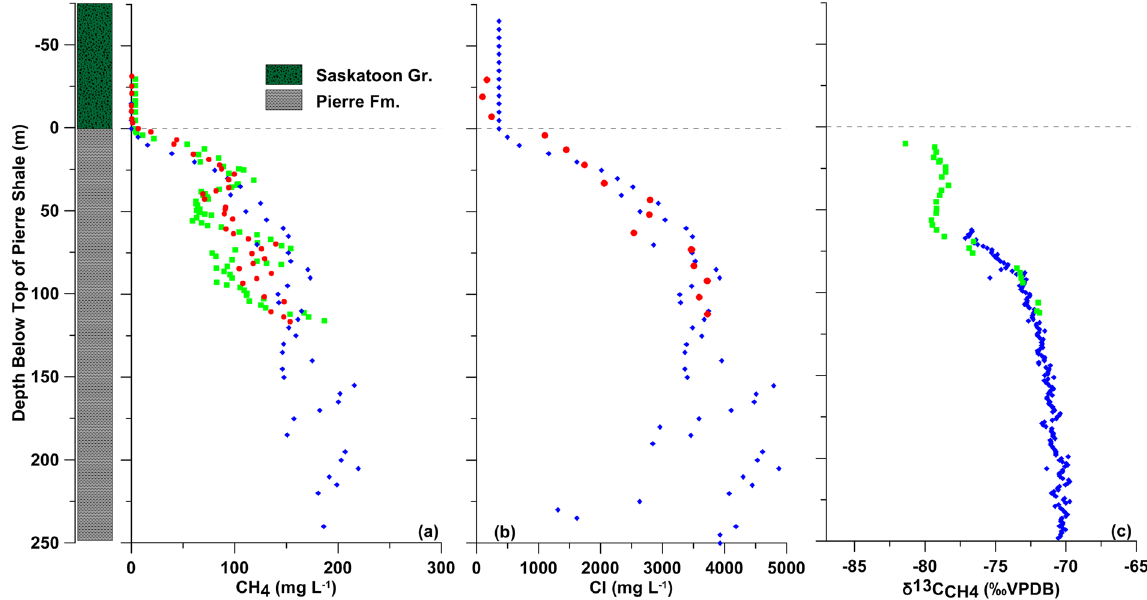
Figure 2. Geology (Site 2) and dissolved CH 4 concentrations ( a ), Cl − concentrations ( b ), and δ 13 C-CH 4 values ( c ) vs. depth below the top of the Pierre Shale at Sites 2 and 6. The Isojar ® data from Site 2 are shown as solid red dots, and mud gas data from Sites 2 and 6 as solid green squares and solid blue triangles, respectively.